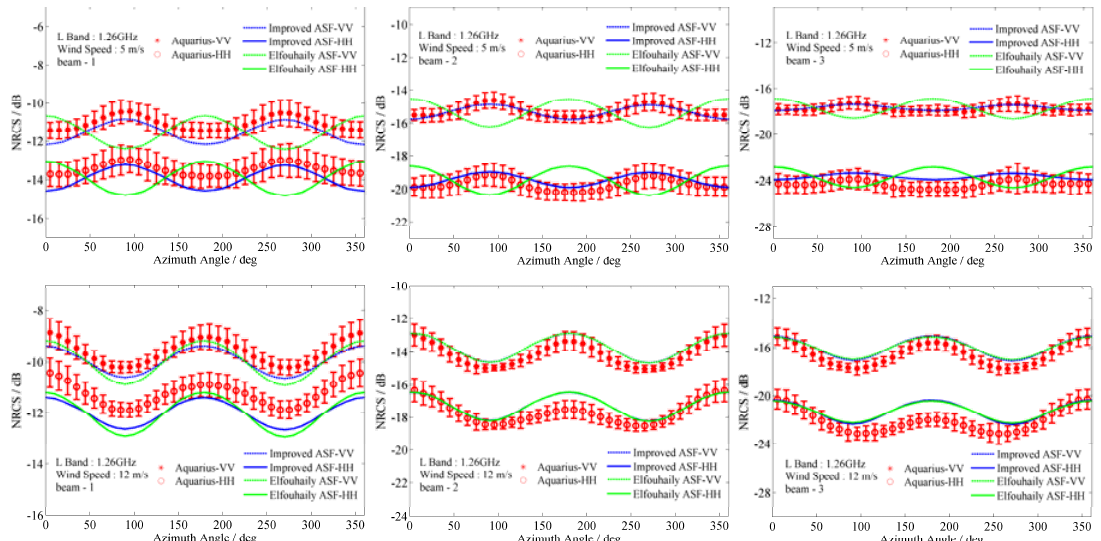
Figure 5. Comparison of azimuthal features of scattering curves between model simulations with two ASFs and satellite observations. The upper and bottom rows represent the wind speed at 5 and 12 m/s wind, respectively. The left column corresponds to beam 1, the middle column corresponds to beam 2, and the right column corresponds to beam 3. Here, beams 1, 2 and 3 denote the incidence angles of 28.7 ◦ , 37.8 ◦ and 45.6 ◦ , respectively. Red stars and circles are the binned matchup averages for VV and HH polarization, respectively; the vertical bars represent ± 1 SD of the matchup data. Dash lines and solid lines are model simulations for VV and HH polarization, respectively. Green and blue lines denote the model simulations with Elfouhaily’s ASF and our improved ASF, respectively.